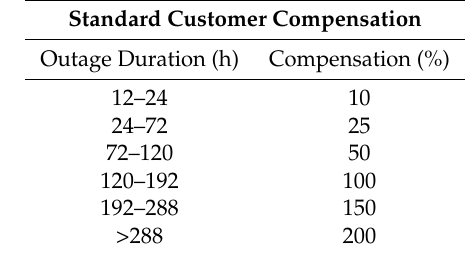
Table 3. The standard customer compensations according to legislation accepted during 2013.